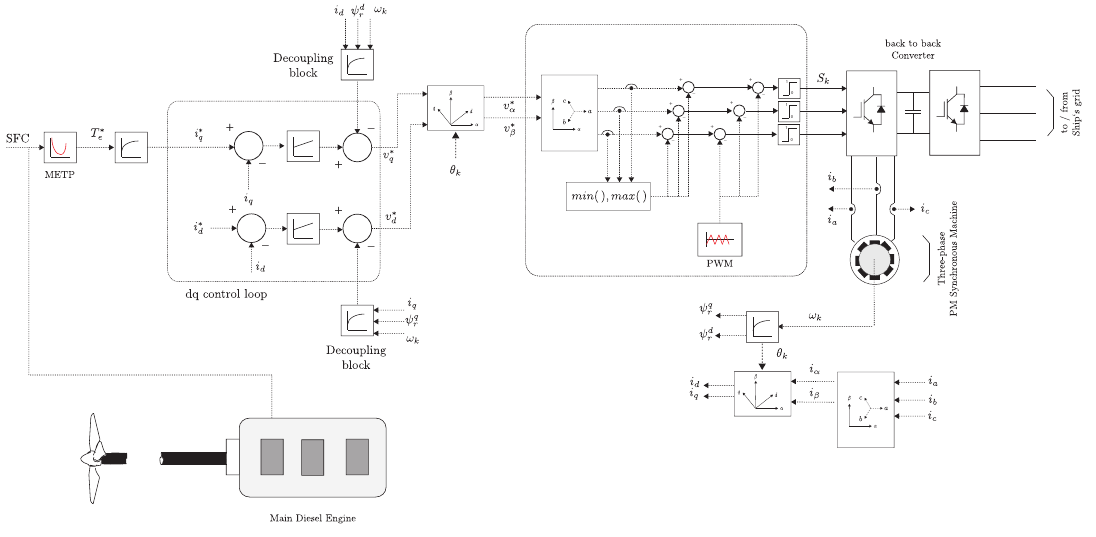
Figure 4. Torque field-oriented control